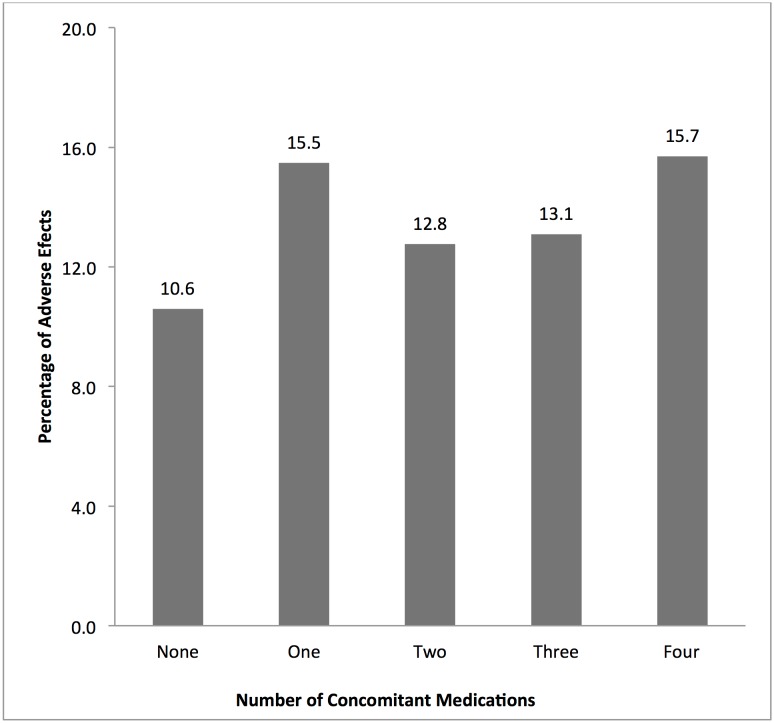
The relationship between the incidence of reported adverse events per number of concomitant medications reportedly taken by the study participants during the period.